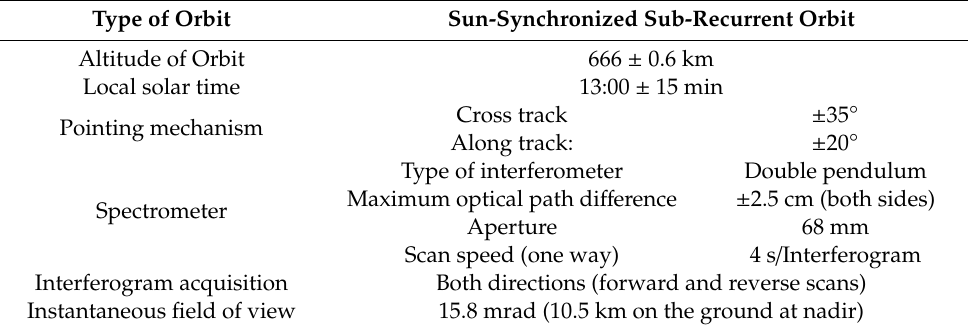
Table 2. Principal specifications of the GOSAT orbit and the TANSO-FTS instrument.